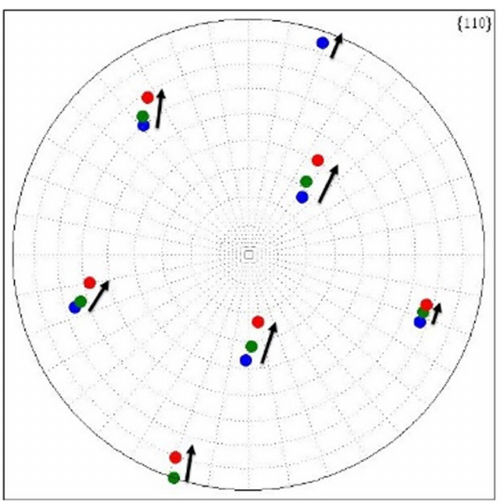
Figure 12. {110} pole figure of specimen treated at 700°C after pin on disc